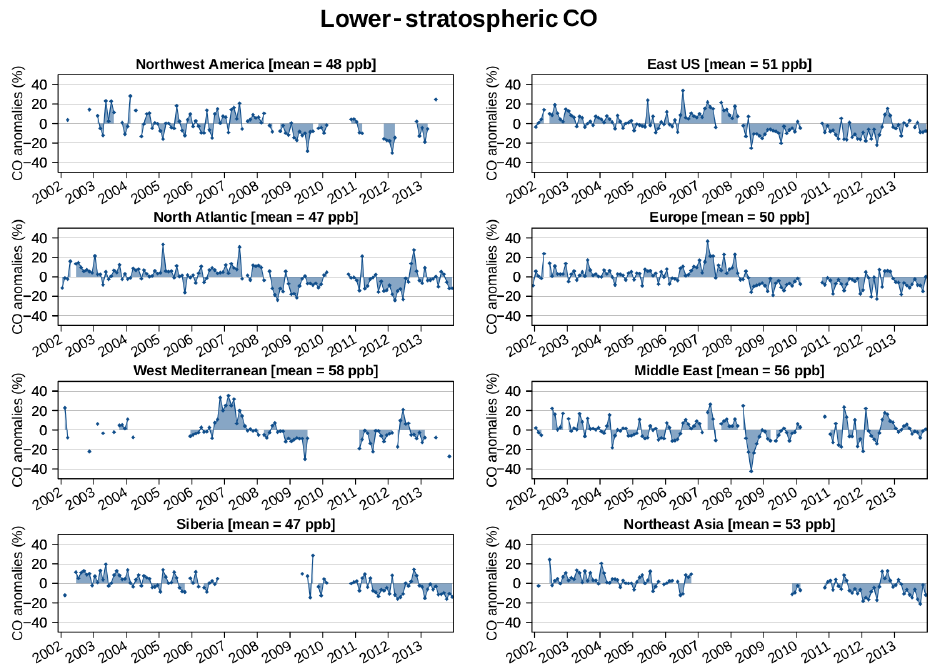
Figure C4. Relative monthly anomalies of CO volume mixing ratio in the lower stratosphere. The units % refer to the corresponding climatological means indicated above each